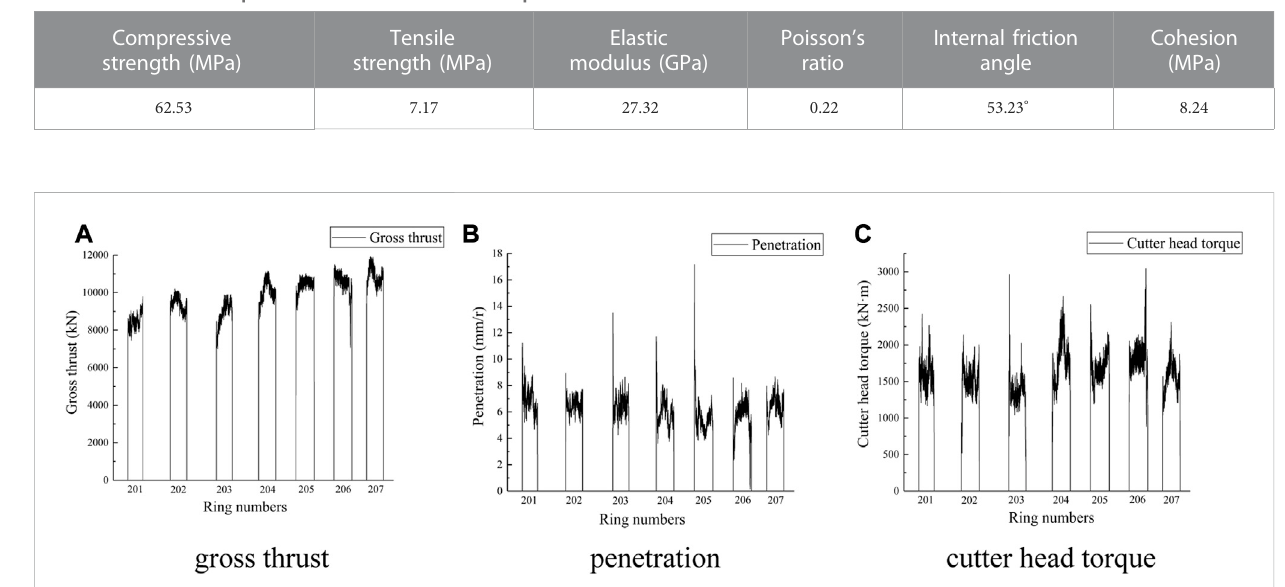
FIGURE 9 The variations of the tunneling parameters from the 201st ring to the 207th ring. (A) gross thrust (B) penetration (C) cutter head torque.